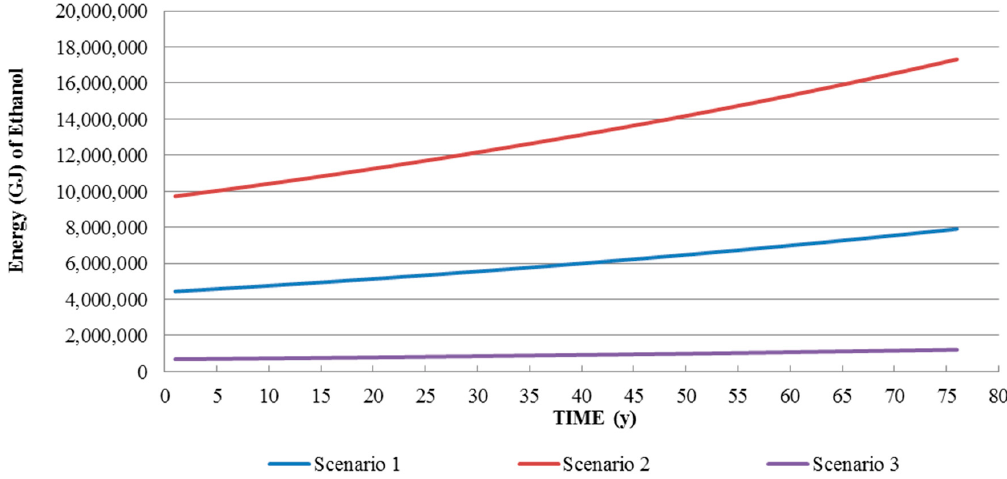
Figure 6. Long term energy probabilities of ethanol from forest biomass in Michigan.